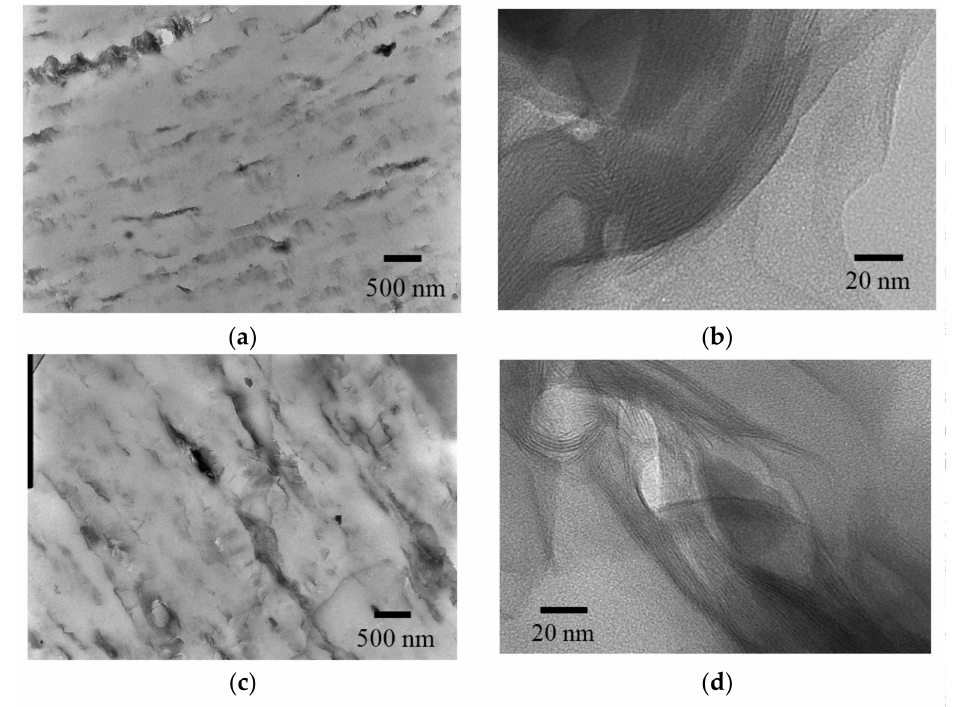
Figure 3. TEM micrographs: ( a ) (ii) 4 DR 5% clay/PLA (10k × ); ( b ) 4 DR 5% clay/PLA (200k × ); ( c ) 4 DR 5% clay/PLA 1000 h degradation (10k × ); ( d ) 4 DR 5% clay/PLA 1000 h degradation (200k ×